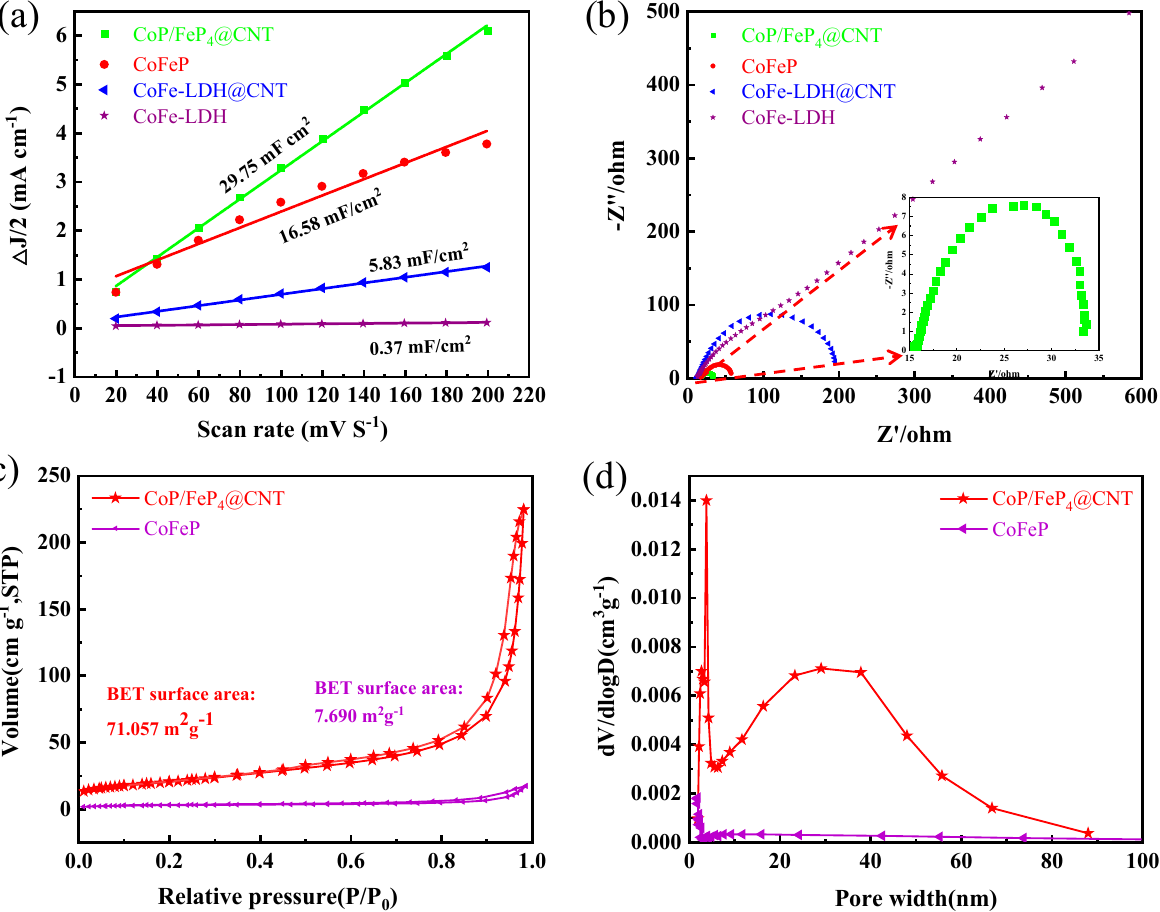
Figure 6. ( a ) Estimated C dl values and relative electrochemically active surface areas, and ( b ) Nyquist plots of CoP/FeP 4 @CNT, CoFeP, CoFe-LDH@CNT and CoFe-LDH. The inset of ( b ) is the magnification of the EIS spectrum of